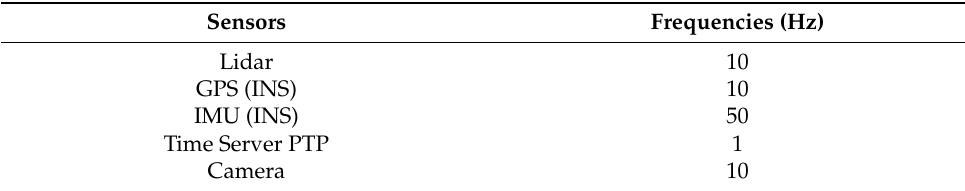
Table 1. Sensor frequencies in standard operating